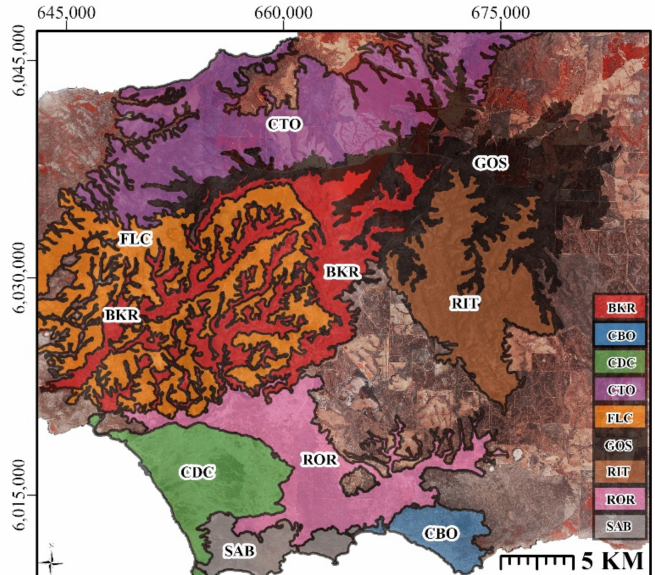
Figure 5. Locations of Landsystem (LS) soil units used for comparing statistics of fire severity indices. Additional descriptions of LS units can be found in Appendix A, Table A1. Soil groups are chosen based on areas with highest severity and within regions of Flinders Chase National Park and Ravine des Casoars Wilderness Protection